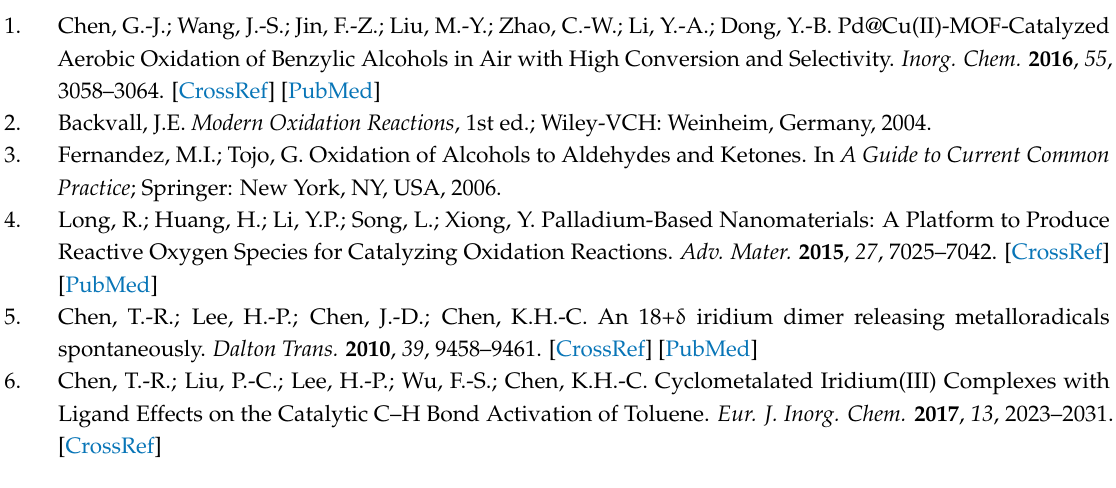
Table S5: Rate constants and activation energy of the catalytic oxidation for toluene, Table S6: Reaction rates, catalytic frequencies, concentration of the product and turnover number of catalytic oxidation of toluene with various concentrations of complexes as